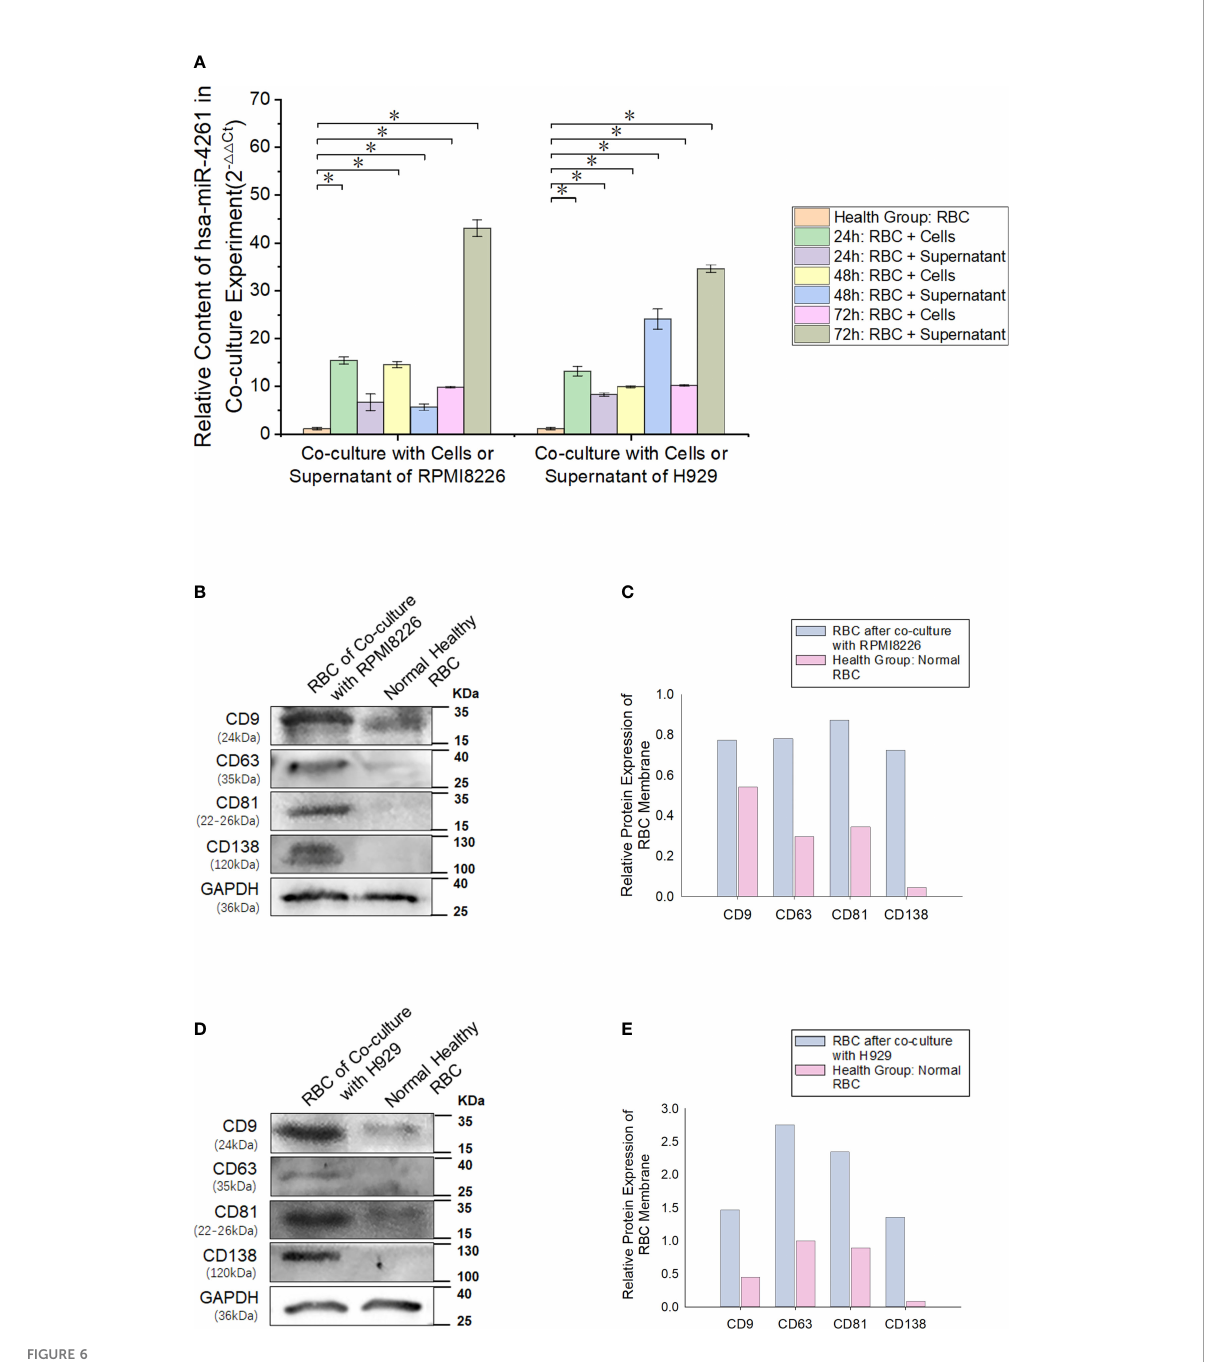
FIGURE 6 MM cell-derived exosomes can transfer miR-4261 to RBCs. (A) Cell coculture experiments show that MM cell lines can deliver miR-4261 to RBCs through the cell culture supernatant (refer to Supplementary Tables 4 and 5 for P values). (B – E) The membrane marker CD138 of MM clonal plasma cells can be detected on the surface of normal RBCs after coculture with RPMI8226 or H929 cells, and the marker expression level of exosomes is signi fi cantly higher than that of normal RBCs (GAPDH was used as an internal control). (Error bars represent the mean ± SEM, * P <